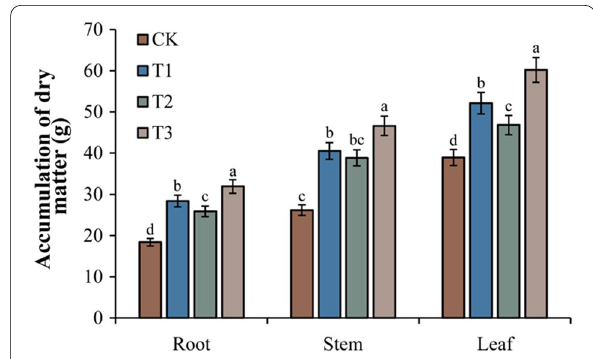
Fig. 8 Accumulation of dry matter contents in different tobacco plant parts under different treatments. According to Duncan’s multiple range test, the significant difference among the treatments is shown by different small letters on the error bars, at P <